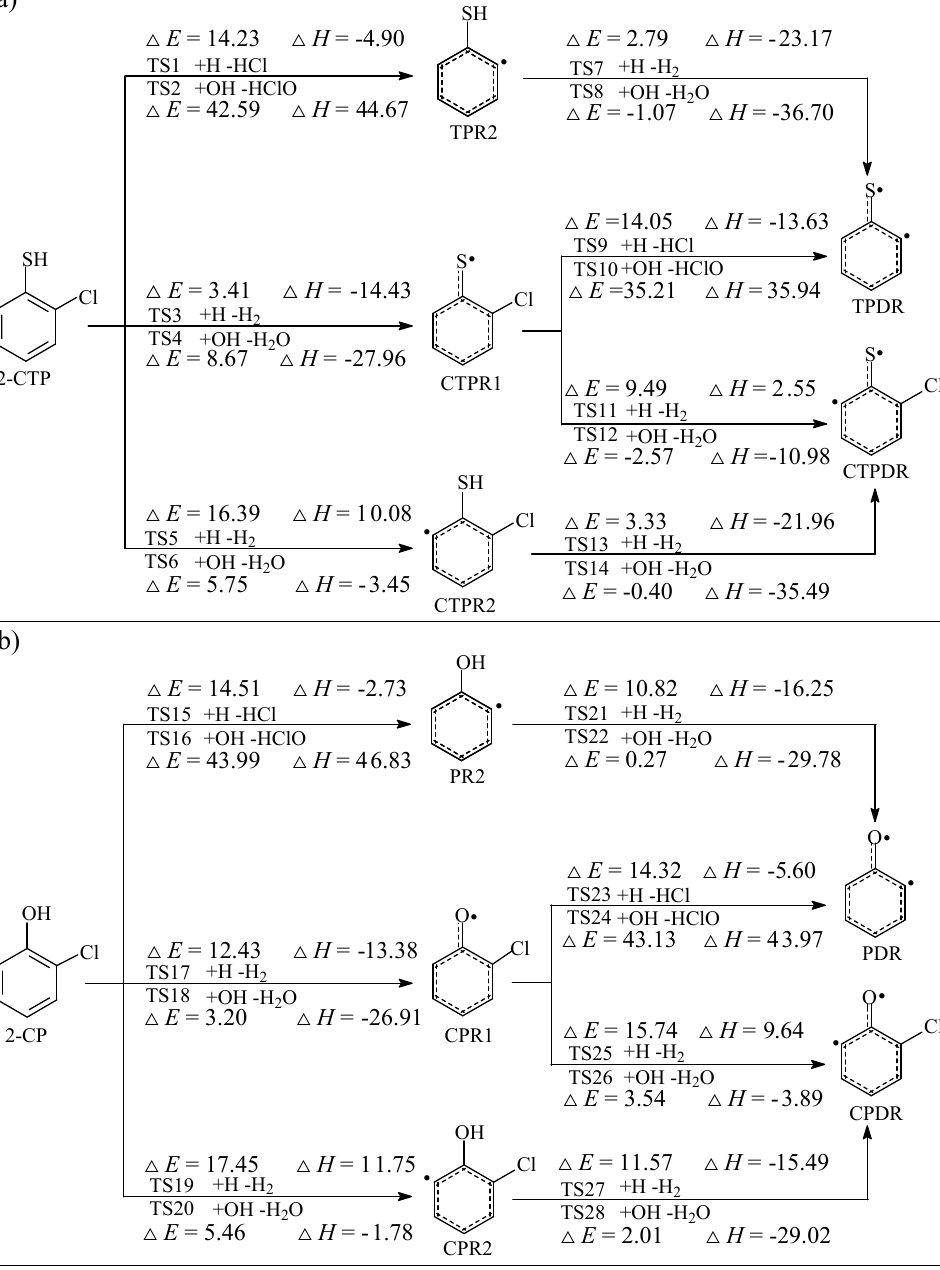
Figure 1. Formation of radical species C(T)PR1, C(T)PR2, C(T)PDR, (T)PR2, and (T)PDR embedded with the potential barriers ∆ E (in kcal/mol) and reaction heats ∆ H (in kcal/mol) from reactions of 2-CTP ( a ) and 2-CP ( b ) with H/OH radicals, respectively. ∆ H is calculated at 0 K.